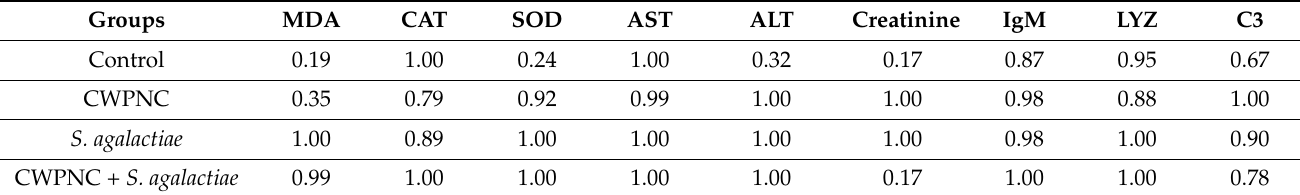
Table 4. Shaprio-Wilk test results for the measured parameters.